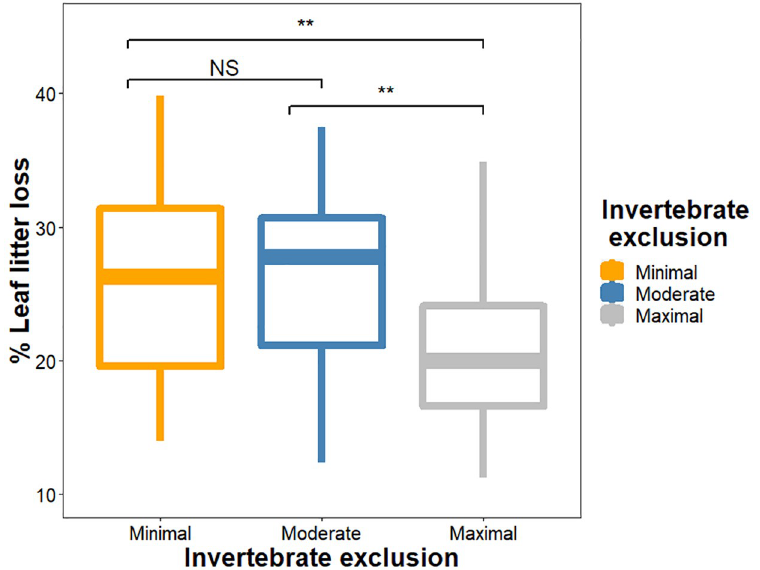
Fig 4. Boxplot showing the relationship between invertebrate exclusion and percent leaf litter lost. Maximal invertebrate exclusion had lower leaf litter loss than minimal and moderate invertebrate exclusion, which in turn did not differ. NS P > 0.05 �� P < 0.01.